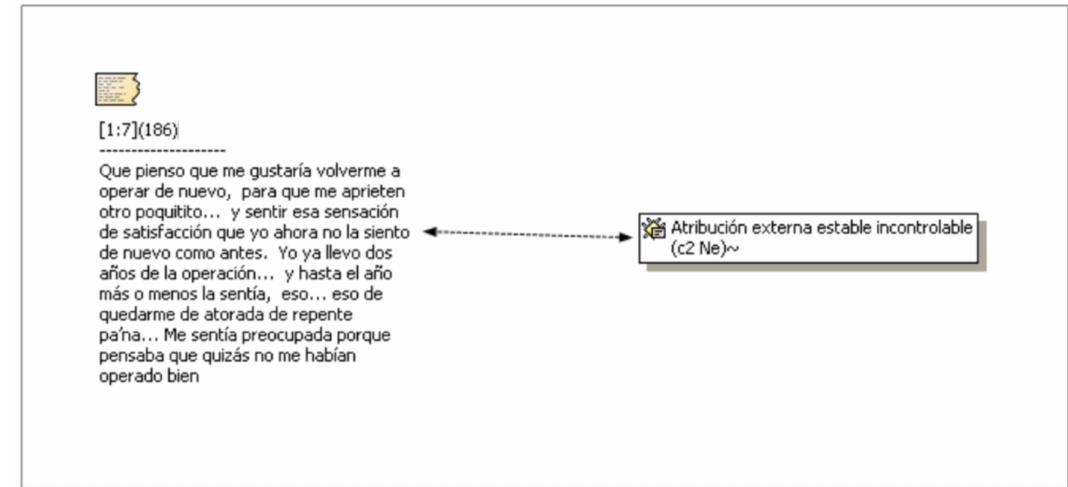
Figure 2. Example of coding with its corresponding excerpt.